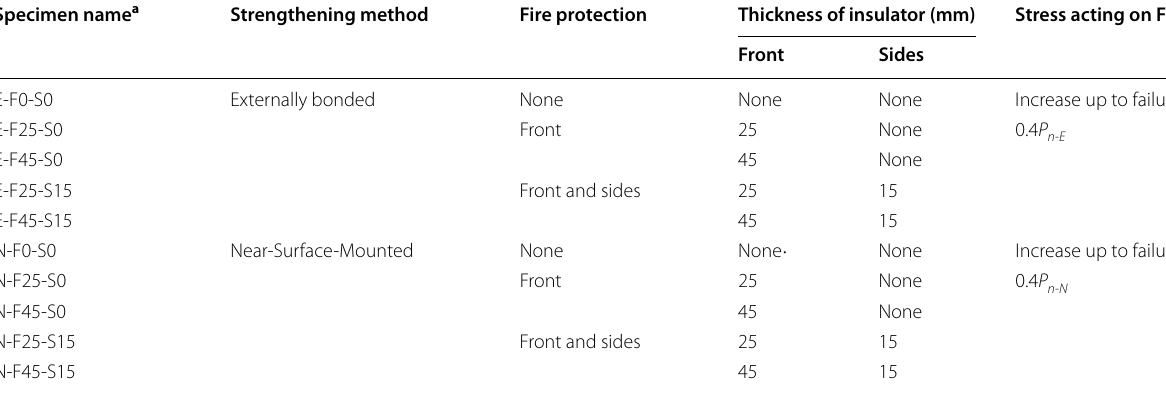
Table 1 Specimen list.